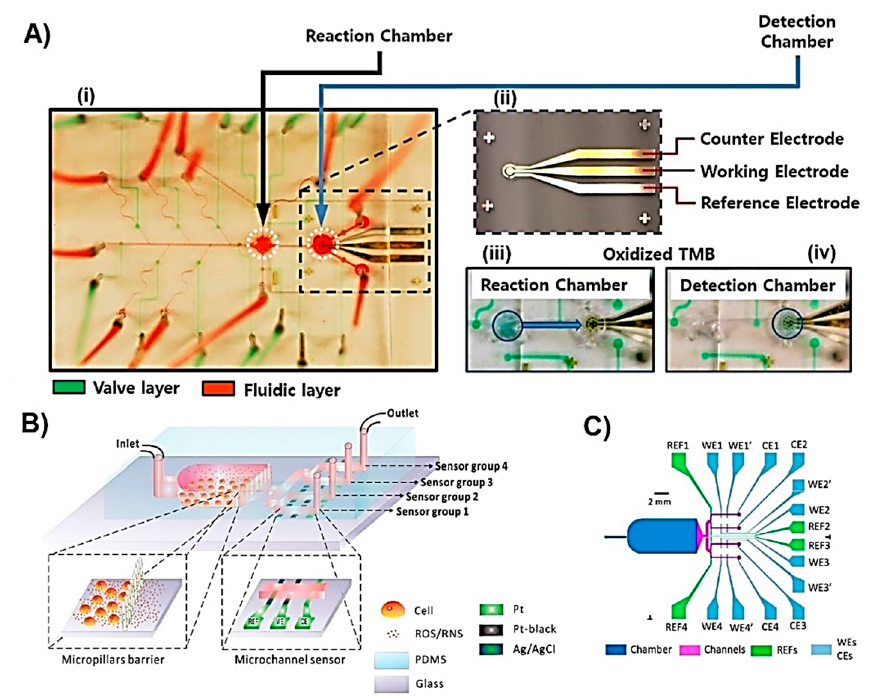
Figure 6. ( A ) Configuration of the fabricated microfluidic sensing chip, (i) photograph of the microfluidic chip with an integrated microelectrode, (ii) only the microelectrode, (iii) the reaction chamber with oxidised TMB, (iv) transfer of oxidised TMB to the detection chamber, reprinted from [93], Copyright (2016) Springer Nature. ( B ) 3D scheme of the microfluidic platform integrating a microchamber upstream for cell culture and four parallel channels with microband electrodes downstream. ( C ) Top view of the microdevice with its microfluidic circuit and electrode paths for electrical connection, reprinted with permission from [85], copyright (2018) American Chemical Society.